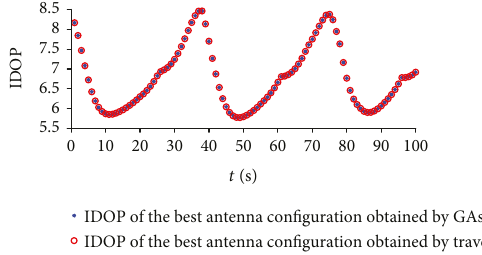
IDOP of the best antenna configuration obtained by GAs IDOP of the best antenna configuration obtained by traversal Figure 5: IDOP with the change of relative attitude of the intersatellite.